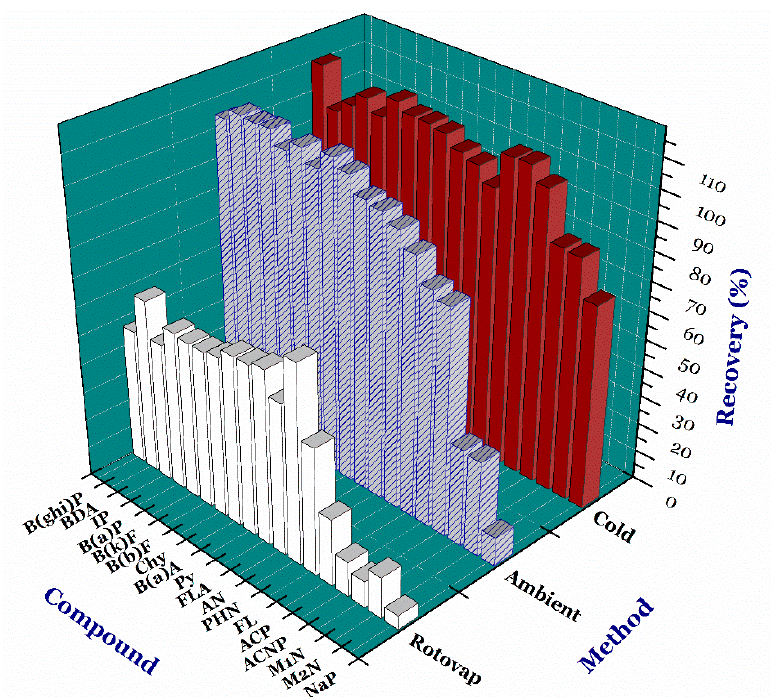
Figure 1. Comparison of recoveries between variable solvent evaporation methods. Note: